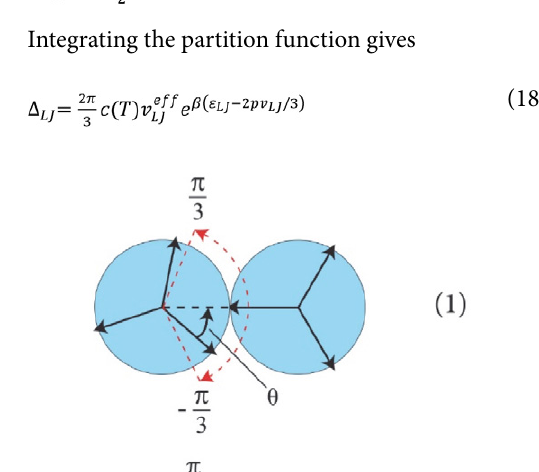
The non-interacting state . In this third possible state, the test water has no interaction with its clockwise